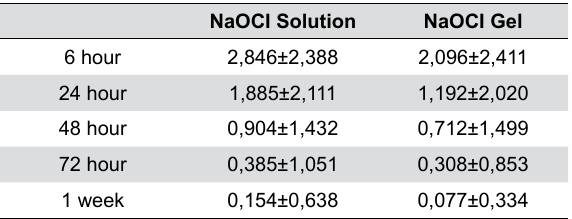
Table 3- The mean and standard deviations of pain score of groups at different time